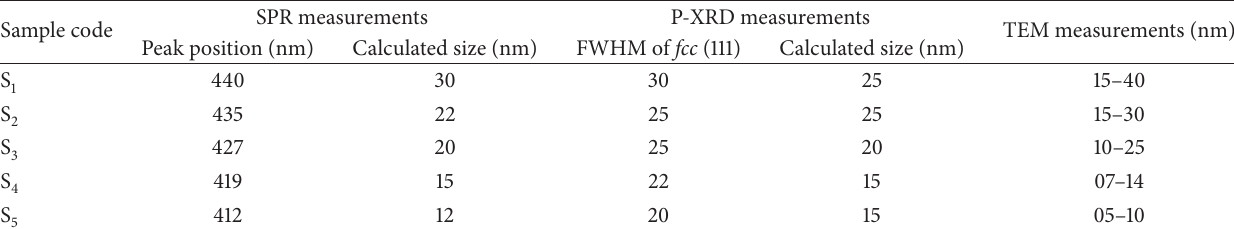
Table 2: Size of silver nanoparticles calculated by using different